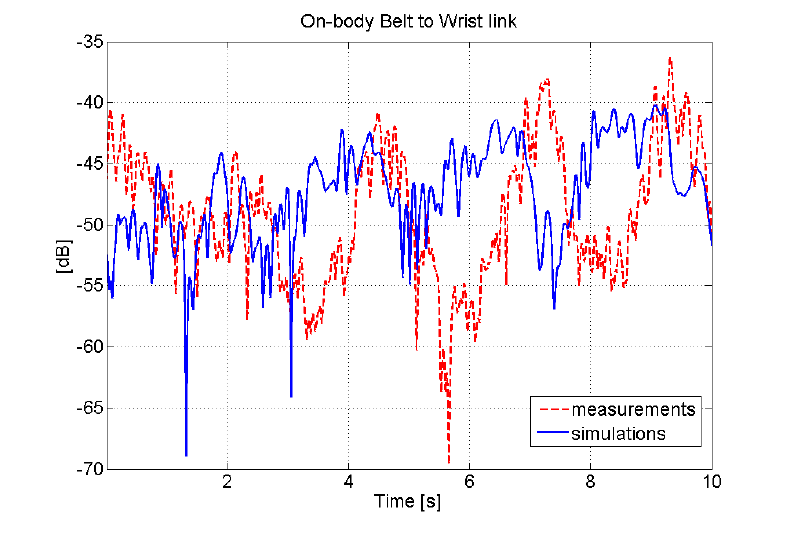
Figure 6. Comparison between measured and implemented belt-to-wrist on-body